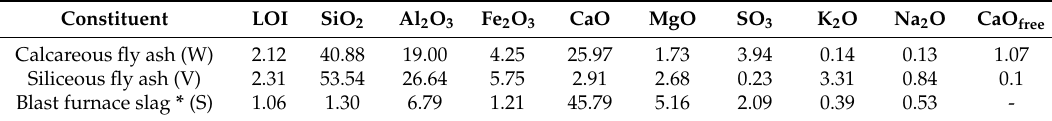
Table 1. Chemical composition of major constituents of blended cements by XRF method, (%). Constituent LOI